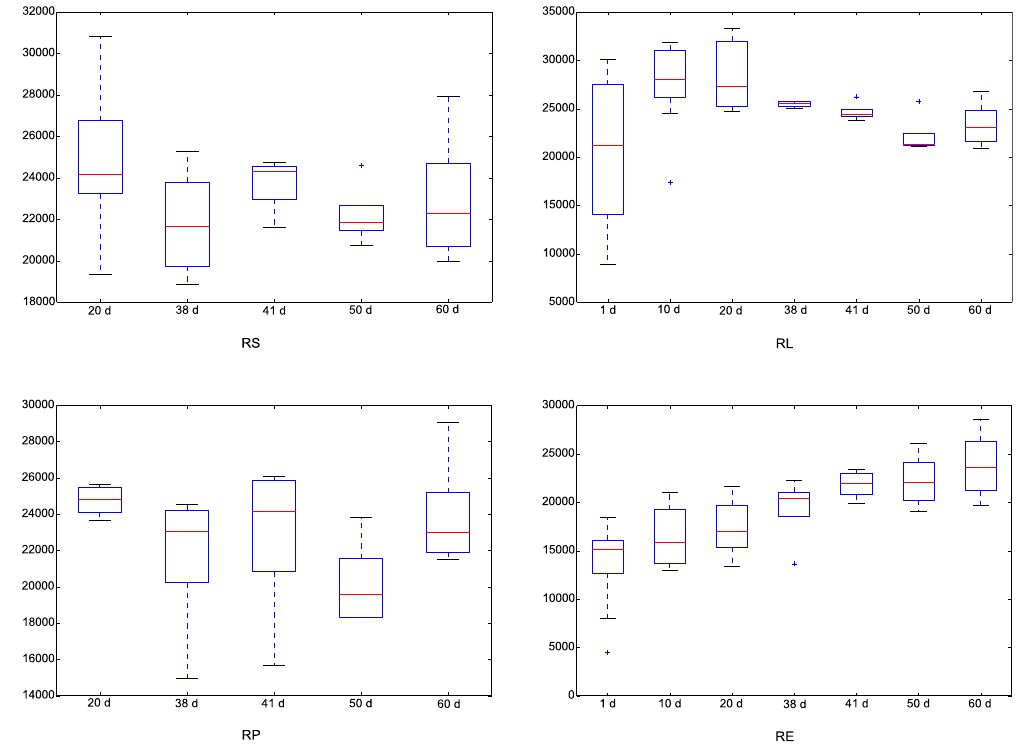
Figure 1. Comparison of Chao 1 index of methanogen communities within different ages for each fraction. The horizontal lines in each box indicate the median values, and the 75 th and 25 th quartile values are respectively represented by the top and bottom sides of each